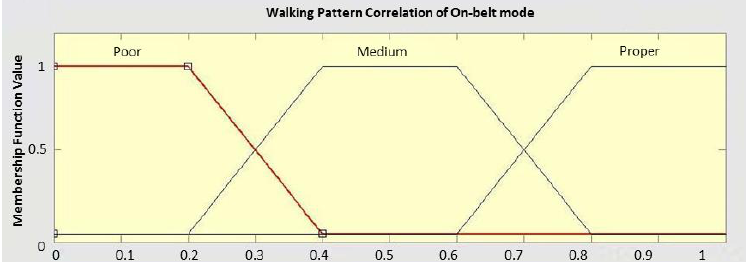
Figure 7. Fuzzy trapezoidal membership function defined for the walking pattern correlation.